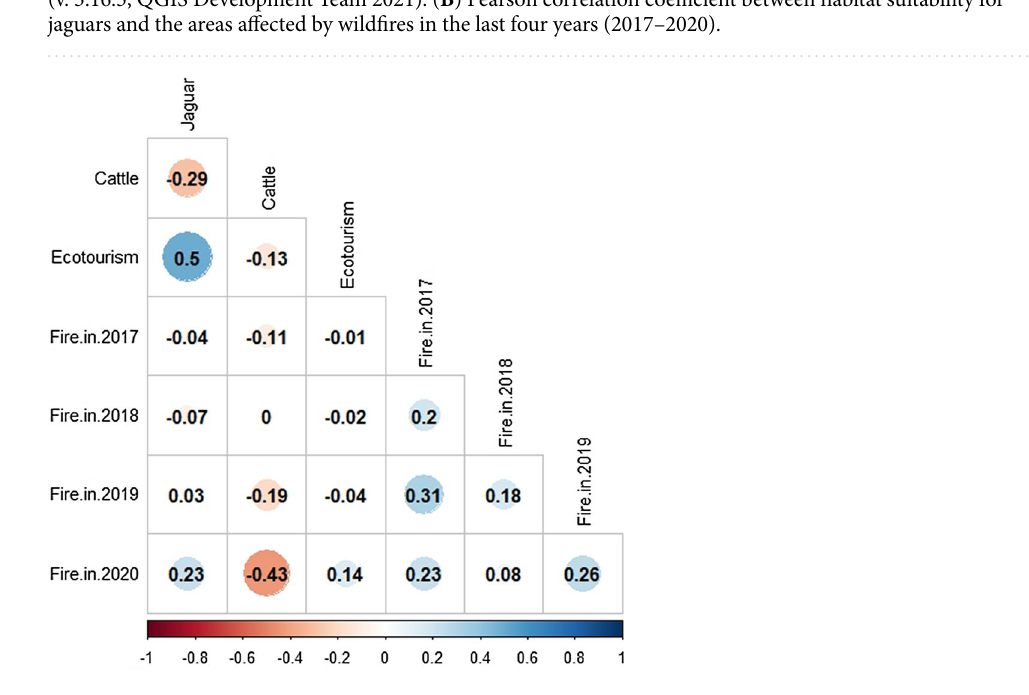
Figure 2. Correlation matrix between jaguar habitat suitability (Jaguar), cattle stocking density (Cattle), lodge density (Ecotourism), and incidence of annual burnt areas (Fire) between 2017 and 2020 in the Brazilian